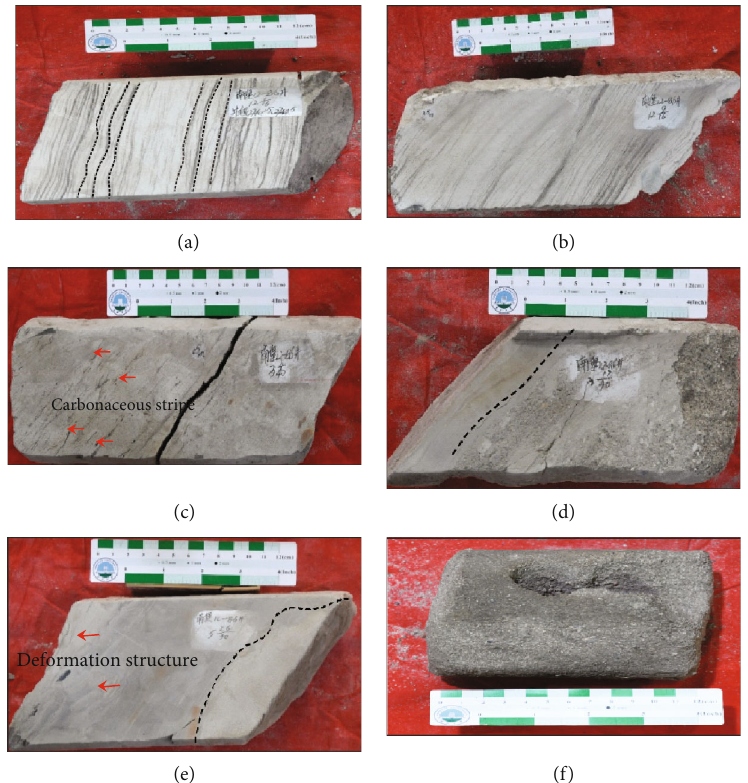
Figure 4: Sedimentary tectonic features of Nanpu 1-29 Area. (a) Wavy bedding, the bedding units that are symmetrical or asymmetrical wavy. (b) Ripple lamination fi ne sandstones, whose composition, color, and grain size change along the direction of sediment accumulation. (c) Veined carbonaceous fi ne sandstone, the sandstone is relatively su ffi cient, and there are abundant carbonaceous strips. (d) Massive bedding fi ne conglomerate, developed at the bottom of a river with a scour surface visible. (e) Sandy mass, which belongs to abnormal predrainage deposition, with deformation structure visible. (f) Massive bedded coarse sandstone, formed by rapid fl uvial